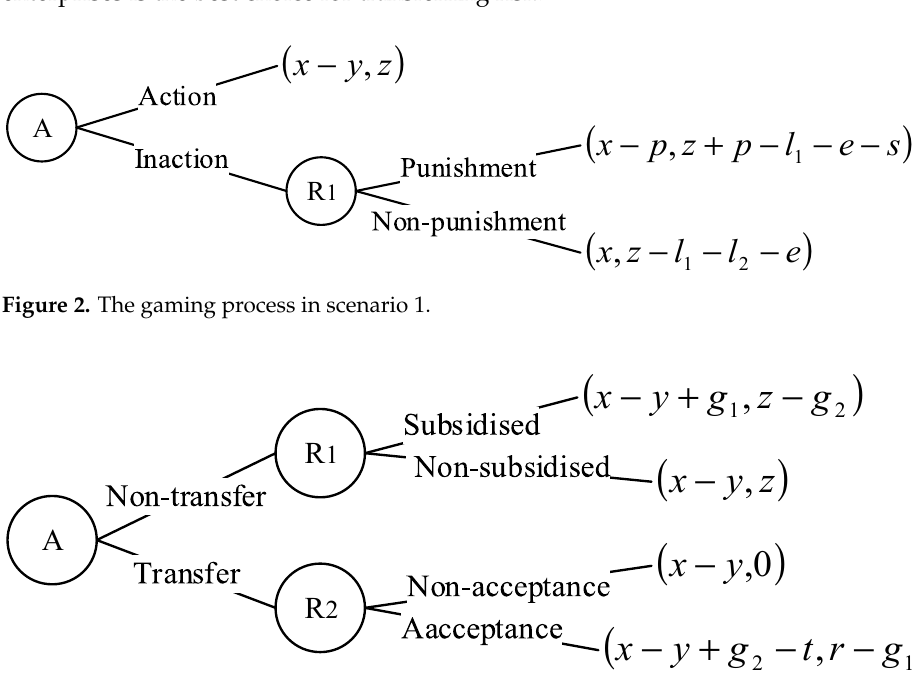
Figure 3. The gaming process in scenario 2.